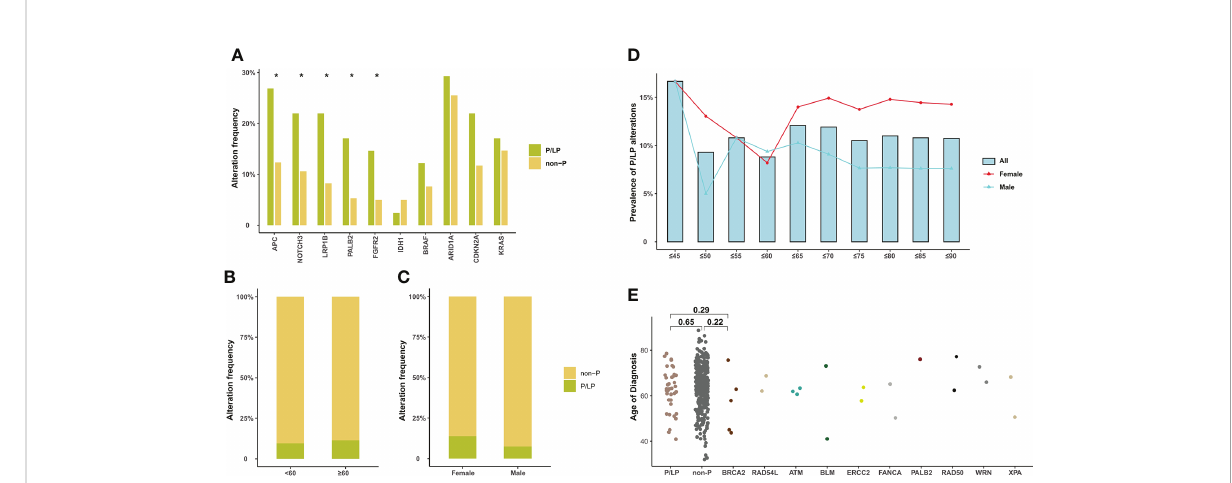
FIGURE 3 Somatic alteration characteristics of BTC patients with P/LP germline alterations and the correlation of P/LP germline alterations with clinical phenotypes. (A) Commonly somatic alterations in BTC patients with and without P/LP germline alteration. * p < 0.05. The correlation between P/ LP germline alterations and (B) age or (C) gender. (D) Frequency of P/LP germline alteration in patients of different ages (372 patients with age information). The bar plot and lines show the frequency of P/LP germline alteration in patients under a certain age (bar) and frequency in female and male patients (lines). (E) The panel shows the age at diagnosis of patients without P/LP germline alterations and patients with different P/LP germline genes. BTC, biliary tract cancer; P/LP, pathogenic or likely pathogenic.